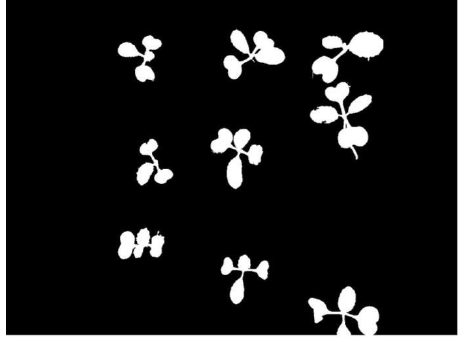
Figure 17. Morphological processing image.